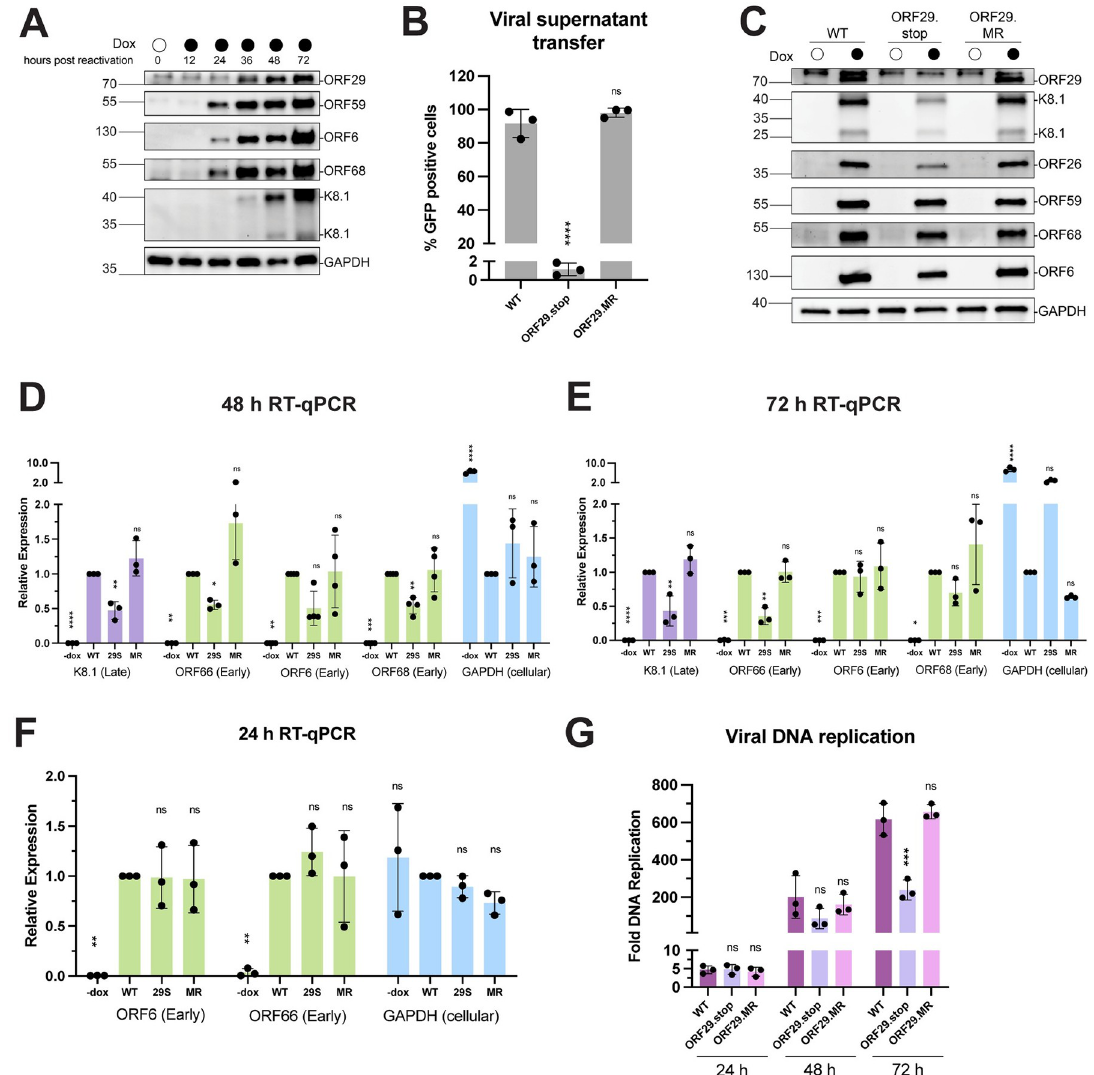
Fig 4. Loss of ORF29 impairs late gene transcription. (A) Western blot showing the expression kinetics of ORF29 relative to the early proteins ORF59, ORF6, and ORF68, and the late protein K8.1 in reactivated WT iSLK cells. (B) Infectious virion production from reactivated iSLK cells was measured by viral supernatant transfer using flow cytometry. Data are from three independent biological replicates, **** = P < 0.0001. P values calculated from ordinary one-way ANOVA test. (C) Representative western blots of lysates harvested from iSLK cells at 72 h post reactivation. Levels of the late proteins, K8.1 and ORF26, are shown, as are levels of the early proteins, ORF6, ORF59, and ORF68. GAPDH serves as a loading control. (D) RNA levels of the indicated genes were measured by RTqPCR. Reactivated cells were harvested at 48 h post reactivation. Data are from three independent biological replicates, normalized to WT for each transcript, **** = P < 0.0001, ** = P < 0.005, * = P < 0.05. P values calculated from ordinary one-way ANOVA test. (E) RNA levels of the indicated genes were measured by RTqPCR. Reactivated cells were harvested at 72 h post reactivation. Data are from three independent biological replicates, normalized to WT for each transcript, **** = P < 0.0001, ** = P < 0.005, * = P < 0.05. P values calculated from ordinary one-way ANOVA test. (F) RNA levels of the indicated genes were measured by RTqPCR. Reactivated cells were harvested at 24 h post reactivation. Data are from three independent biological replicates, normalized to WT for each transcript, **** = P < 0.0001, ** = P < 0.005, * = P < 0.05. P values calculated from ordinary one-way ANOVA test. (G) Viral DNA replication was measured using qPCR in cells harvested 24, 48, and 72 h post reactivation. Fold DNA replication values were calculated by comparing reactivated to non-reactivated cells. Data are from three independent biological replicates, * = P < 0.05. P values calculated from ordinary one-way ANOVA test.